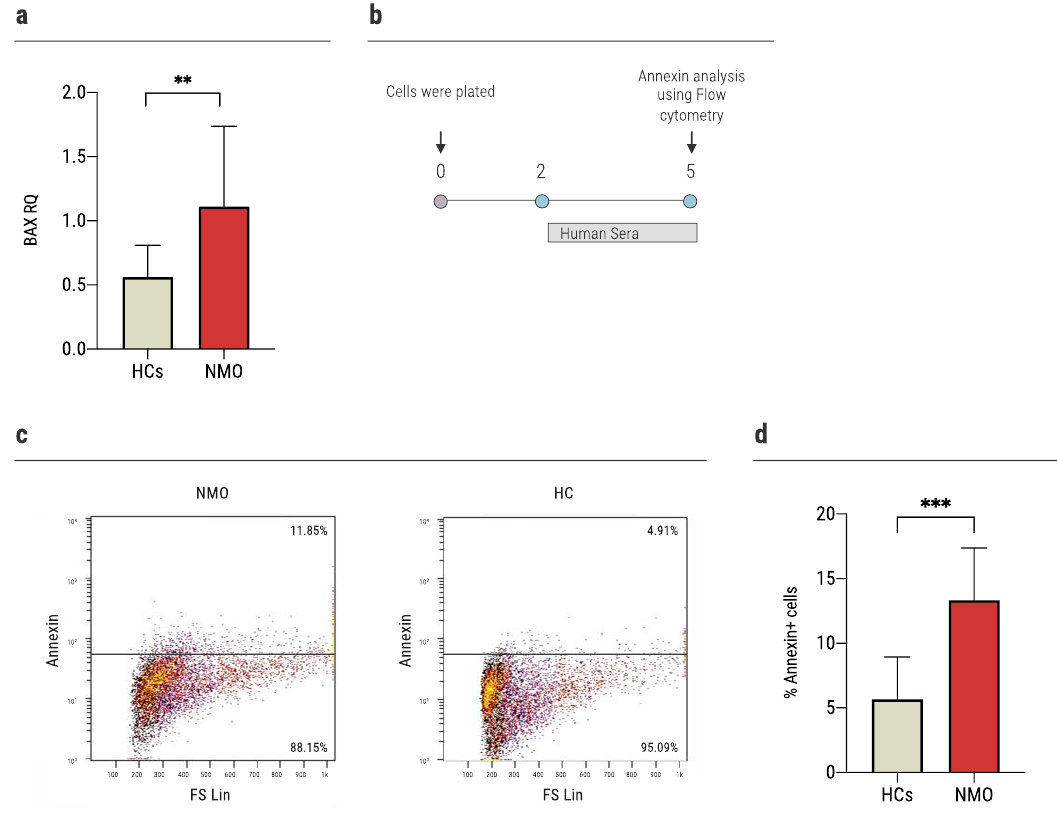
Figure 4. Exposure of NMO sera increased apoptosis in astrocytes. ( a ) The expression of BAX increased significantly in the astrocytes cultured with sera of NMO patients (1.11 ± 0.62, n = 17) vs. 0.56 ± 0.24 ( n = 13) of the HCs, as was determined using rt-QPCR, ( b ) time-course experiments of annexin levels. Primary astrocytes were cultured with human sera (20% of media) for 72 h, followed by evaluation of apoptosis expression using flow cytometry, ( c ) representative flow cytometry analysis of apoptotic astrocytes upon culture with sera obtained from seropositive NMO patients or HCs, ( d ) higher levels of apoptosis among astrocytes cultured with sera of NMO patients (13.34 ± 4.03%, n = 10), compared to HCs (5.7 ± 3.3%, n = 10), as evaluated using annexin staining. Each assay was repeated independently at least three times. Significance was determined by unpaired two-tailed student’s t -test ( p ** ≤ 0.01, *** ≤ 0.001). Error bars in all graphs represent standard deviation.